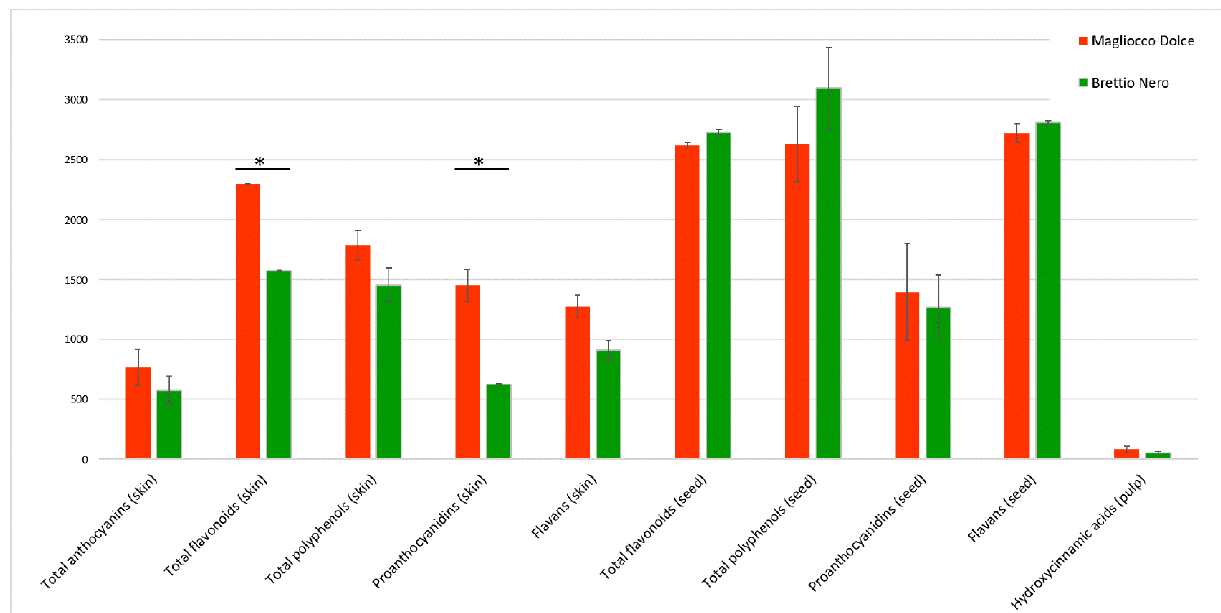
Figure 3. Polyphenols content measured in berry of Magliocco Dolce and Brettio Nero at maturity. Data were collected for two seasons (2016–2017). Standard unpaired Student’s t -test was used for comparison of two varieties, * p < 0.05.